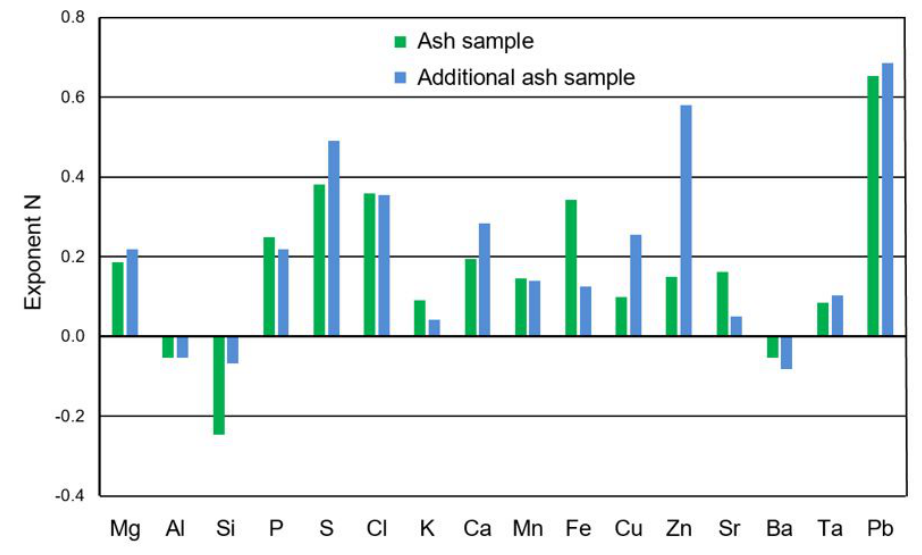
Figure 5. Comparison of the exponents of the two